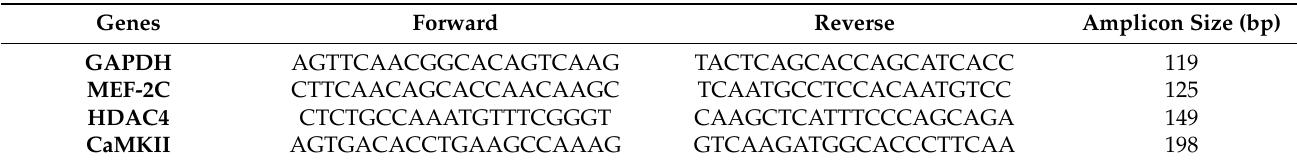
Table 2. The sequence of primers for quantitative real-time polymerase chain reaction (RT-PCR). Genes